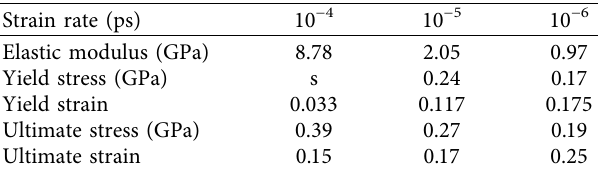
Figure 6: Stress-strain behavior of amorphous system at three strain rates, and the corresponding strain in the Y -direction and the Z -direction. Table 3: Mechanical properties of amorphous system at three strain rates.